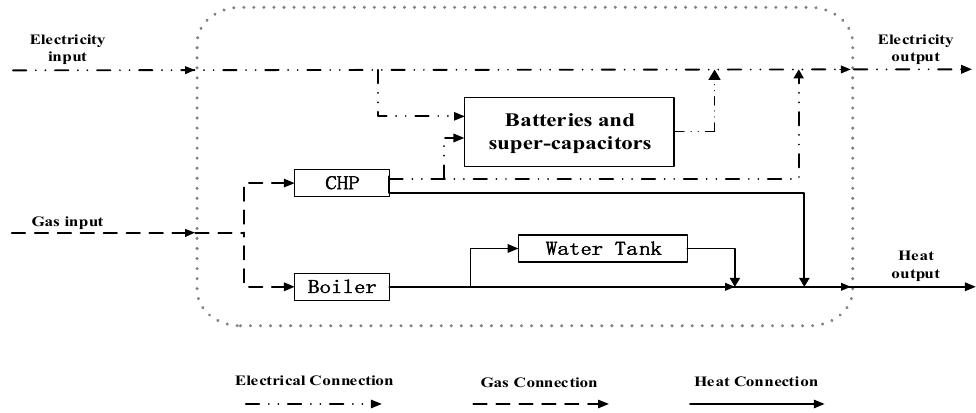
Figure 2. An example of Energy Hub model that contains a combined heat and power (CHP), a boiler, a hybrid electrical storage system and a water tank heat storage system.